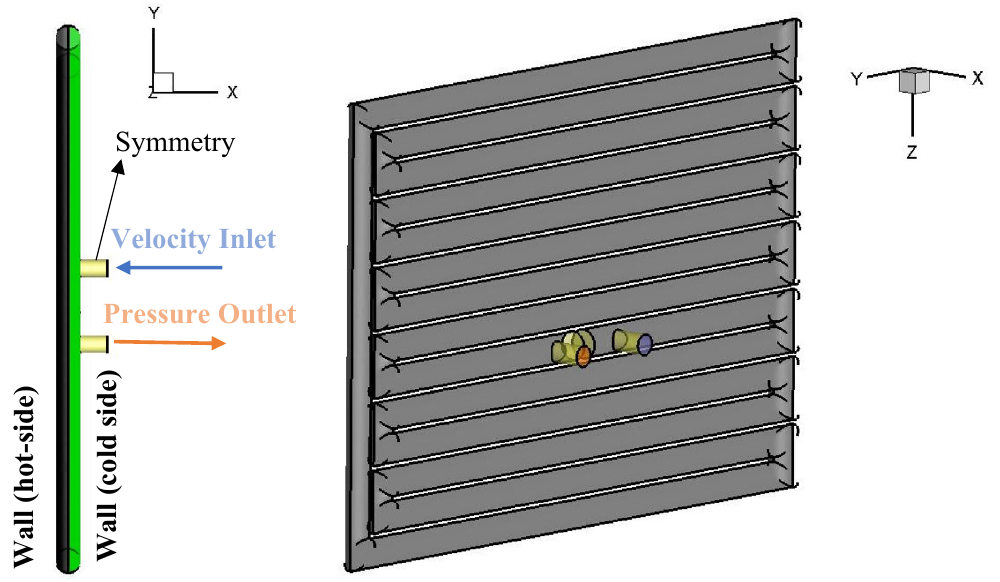
Fig. 7 Boundary conditions for second step (WCP internal flow) simulation; Blue: velocity inlet, Red: pressure outlet, Yellow: symmetry, Gray: wall